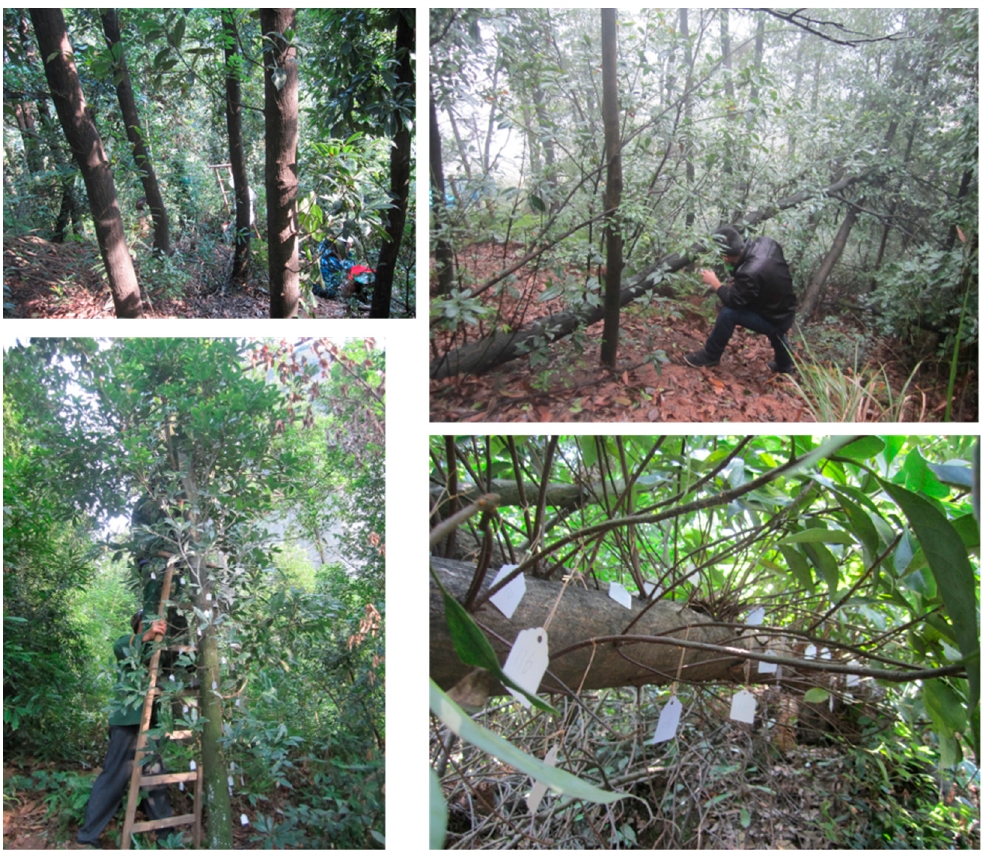
Figure 1. The field picture of Schima superba forest and the sprout measurement following the 2008 ice storm.